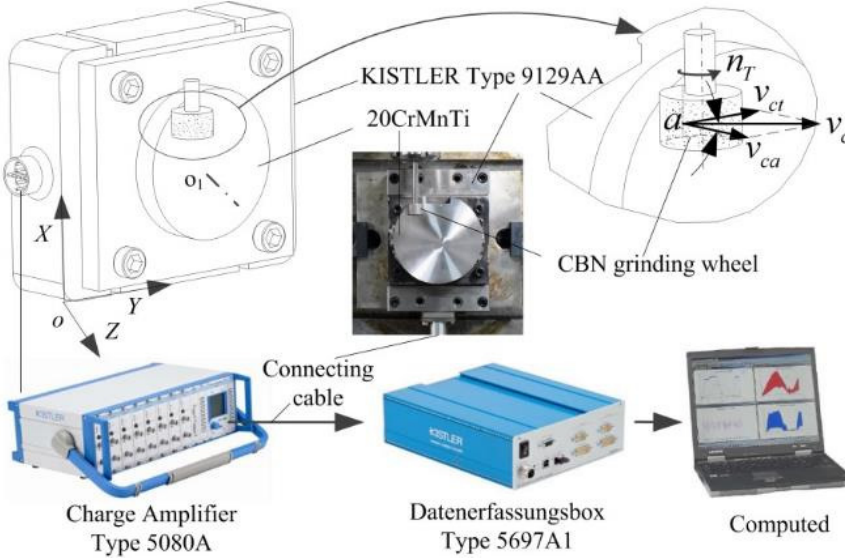
Figure 6. Experimental system of honing force for multi-grain micro-edge honing.